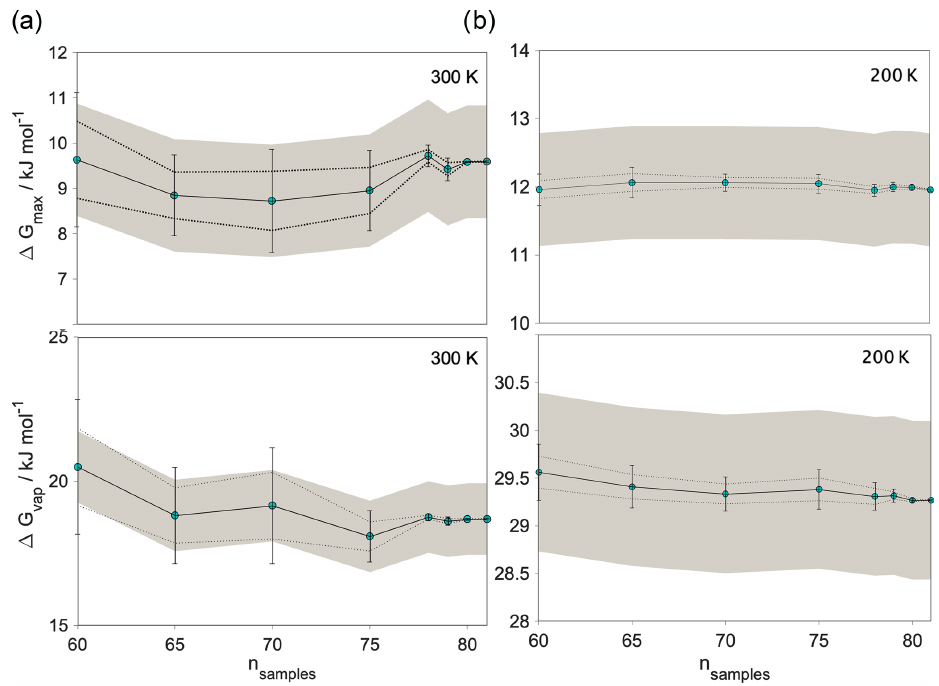
Figure C2. (a) Top panel: value of the free energy in the vapor phase at 300K. Bottom panel: the maximum of the free energy in the bulk liquid phase at 300K. (b) Top panel: value of the free energy in the vapor phase at 200K. Bottom panel: the maximum of the free energy in the bulk liquid phase at 200K. The error bars represent 1 standard deviation; dotted lines are the 95% confidence intervals, and the grey-shaded area indicates the region that falls within ± 1 / 2 k B T of the mean